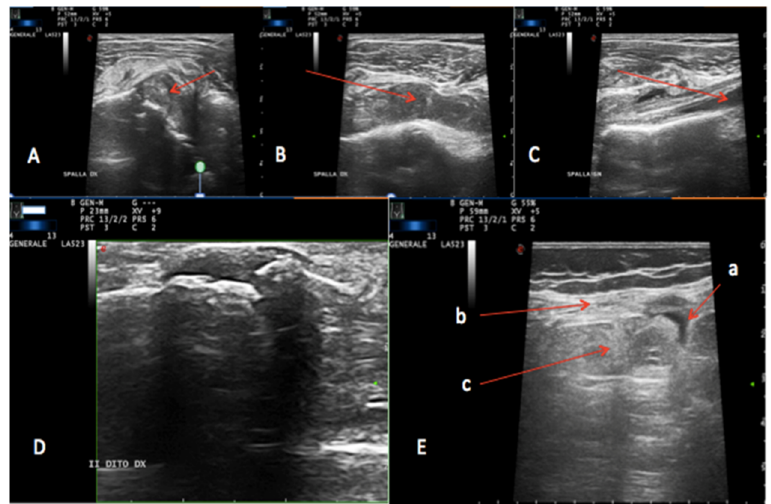
Figure 3. Ultrasound scan. ( A – C ): Left ( A,B ) and right ( C ) shoulder: hypoechoic solid material involving the acromioclavicular joint; ( D ) right hand second finger: hypoechoic solid material involving the proximal and middle phalange articulation; ( E ) right knee articulation: a. suprapatellar